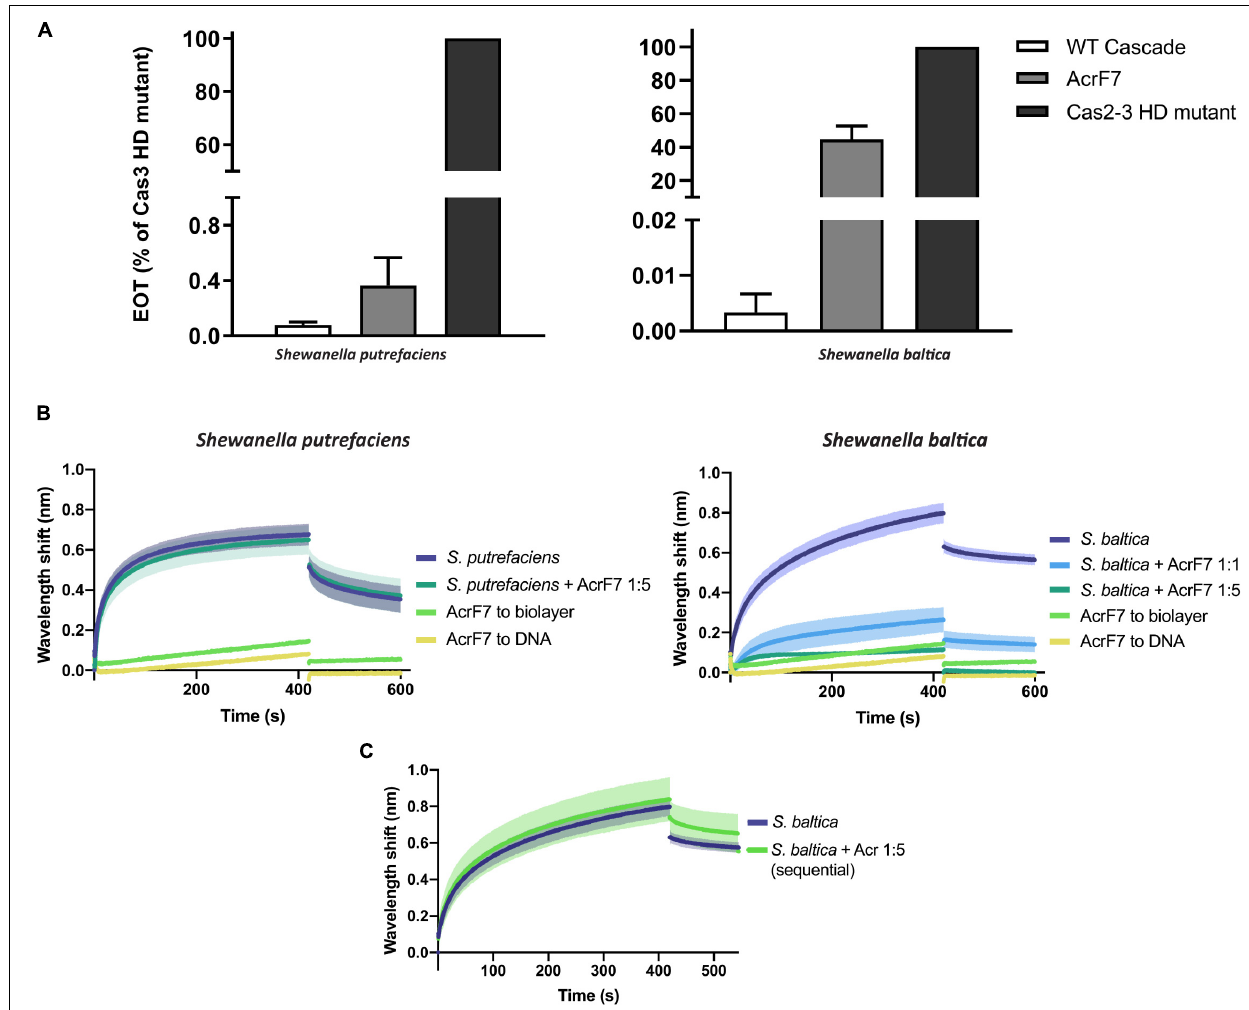
FIGURE 6 | Effect of Anti-CRISPR (Acr) proteins on the binding of CRISPR-Cas complexes to dsDNA. (A) Efficiency of Transformation Assays (EOTs) of CRISPR-Cas systems I-Fv from S. putrefaciens CN-32 (left) and I-F from S. baltica OS195 (right) expressed in E. coli BL21-AI. The activity of the effector complexes was tested when expressed alone (WT Cascade) or co-expressed with AcrF7 from Pseudomonas aeruginosa (Pawluk et al., 2016). EOT equals to the colony ratio between the strain of interest and its corresponding Cas2/3 HD mutant strain, presented as percentages. Error bars represent the SEM. Three replicates were quantified. (B) Wavelength shift (nm) generated by the binding of 500 nM of either Type I-Fv (left) or Type I-F (right) Cascades to complementary oligonucleotide. In order to test the effect of AcrF7, the protein was mixed with Cascades at a 1:1 molar ratio or at a 5-fold molear excess (1:5). Samples were incubated at room temperature for 10 min before analysis. The wavelength shift elicited by the binding of AcrF7 to the dsDNA in the absence of Casade complexees is shown as a control (AcrF7 to DNA). Assays were performed in duplicate. The lighter outlines represent the SEM. (C) Wavelength shift (nm) induced by the binding of 500 nM of S. baltica I-F Cascade to dsDNA oligonucleotide. The effect of AcrF7 on complexes already bound to dsDNA was tested by incubation of the biosensor in BLI buffer containing 2.5 µ M AcrF7 (400 s). Assays were performed in duplicate. The lighter outline represents the SEM.